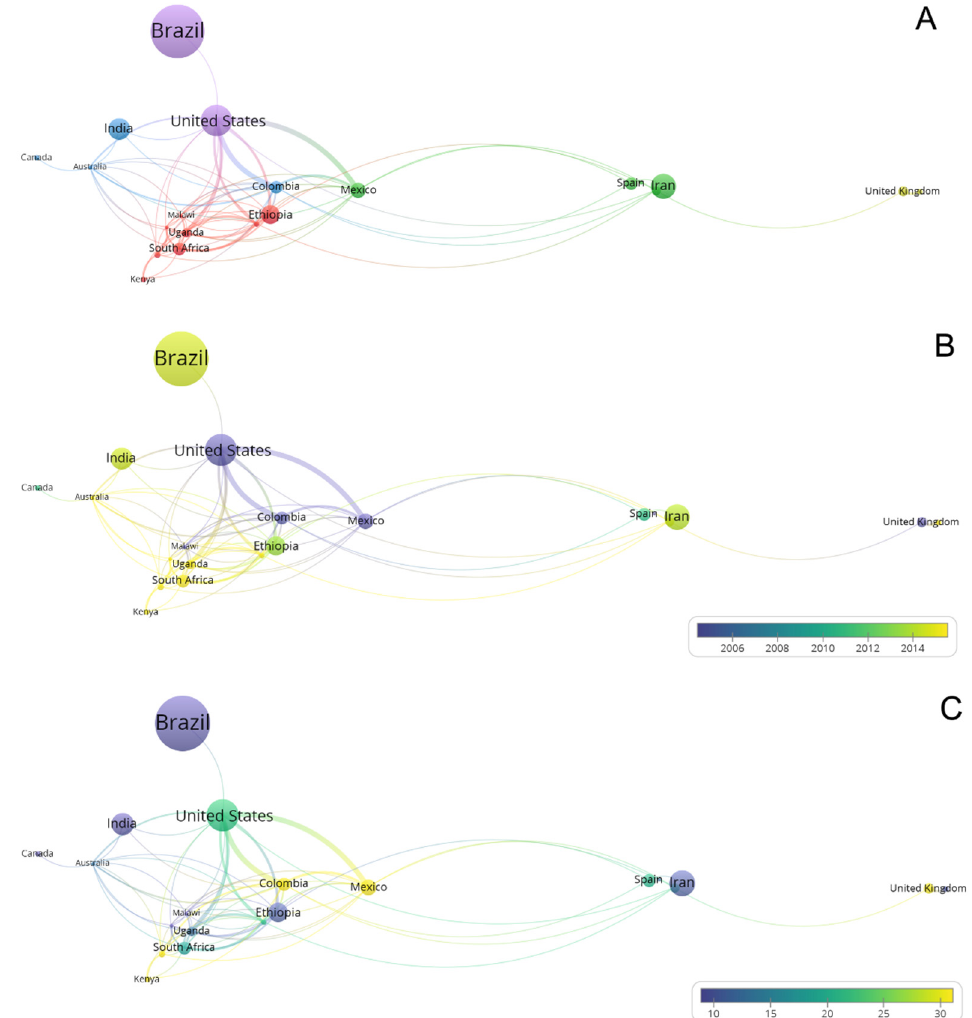
Figure 8. Network of collaboration based on co-authorship between countries that participate with more than 3 publications in the 228 articles included in the systematic review. The size of the circle under the country indicates the number of articles. The connection of the countries with a line shows co-authoring by scientists from the connected countries. ( A ) Network visualization of countries coloured according to the collaborations. Different colours represent different clusters of collaborative countries. ( B ) Evolution of countries in the field of research on agronomic practices that increase yield and quality of common bean coloured by the publication year or ( C ) coloured by the citations received. Produced by VOSviewer.